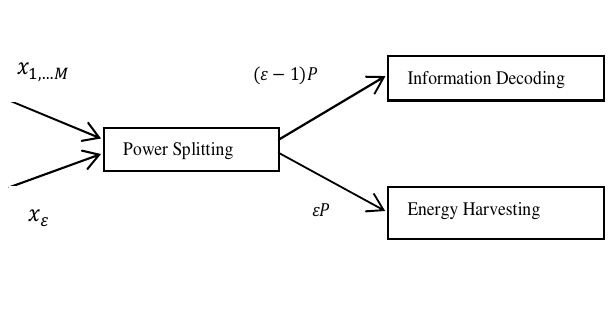
Fig. 3: Energy Harvesting